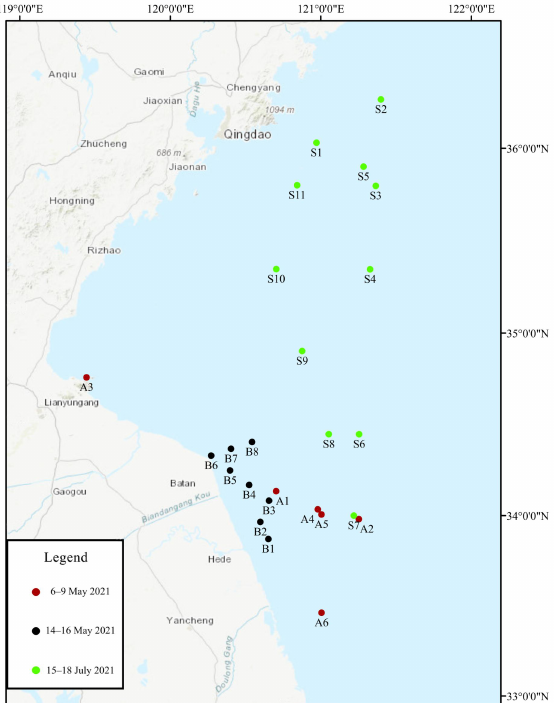
Figure 1. Distribution of green tide outbreak sampling sites in the Southern Yellow Sea in 2021. Different colors represent different sample collection times. Red represents samples collected from 6 May 2021 to 9 May 2021, black represents samples collected from 14 May 2021 to 16 May 2021, and green represents samples collected from 15 July 2021 to 18 July 2021.